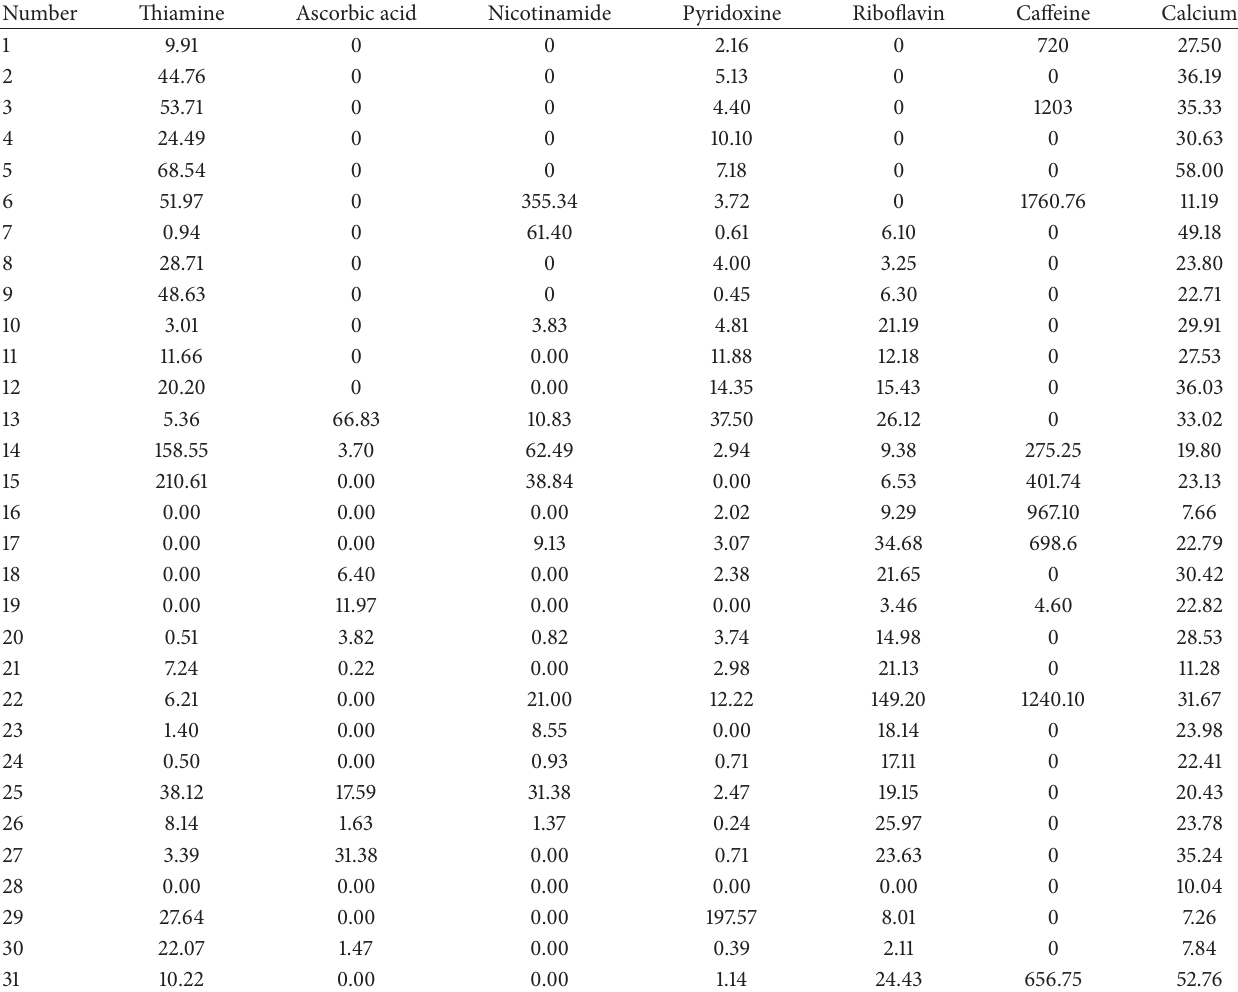
Table 2: The Content of vitamin and mineral of herbal mixtures (mg/100g).